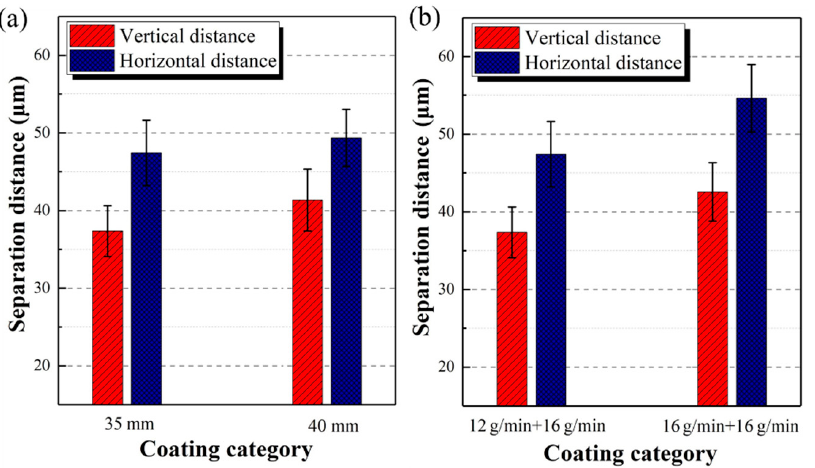
Figure 6. Separation distance distribution of the particles embedded in the matrix coating: ( a ) EMAP TBC prepared with different distances between powder feeder 1 and powder feeder 2, and ( b ) EMAP TBC prepared with different feeding rates for powder feeder 1 and powder feeder 2.